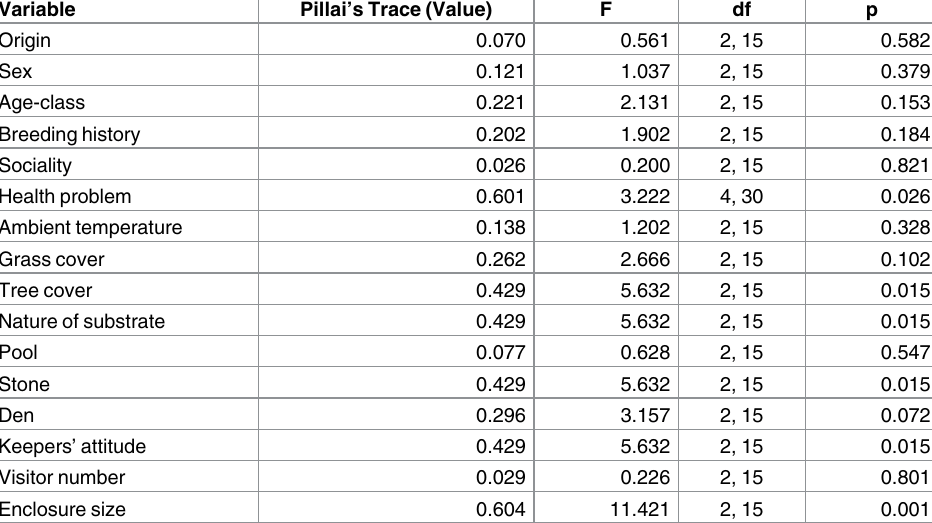
Table 4. MANOVA using stereotypic behaviour and FCM level on various biological and environmen- tal variables among tigers in the